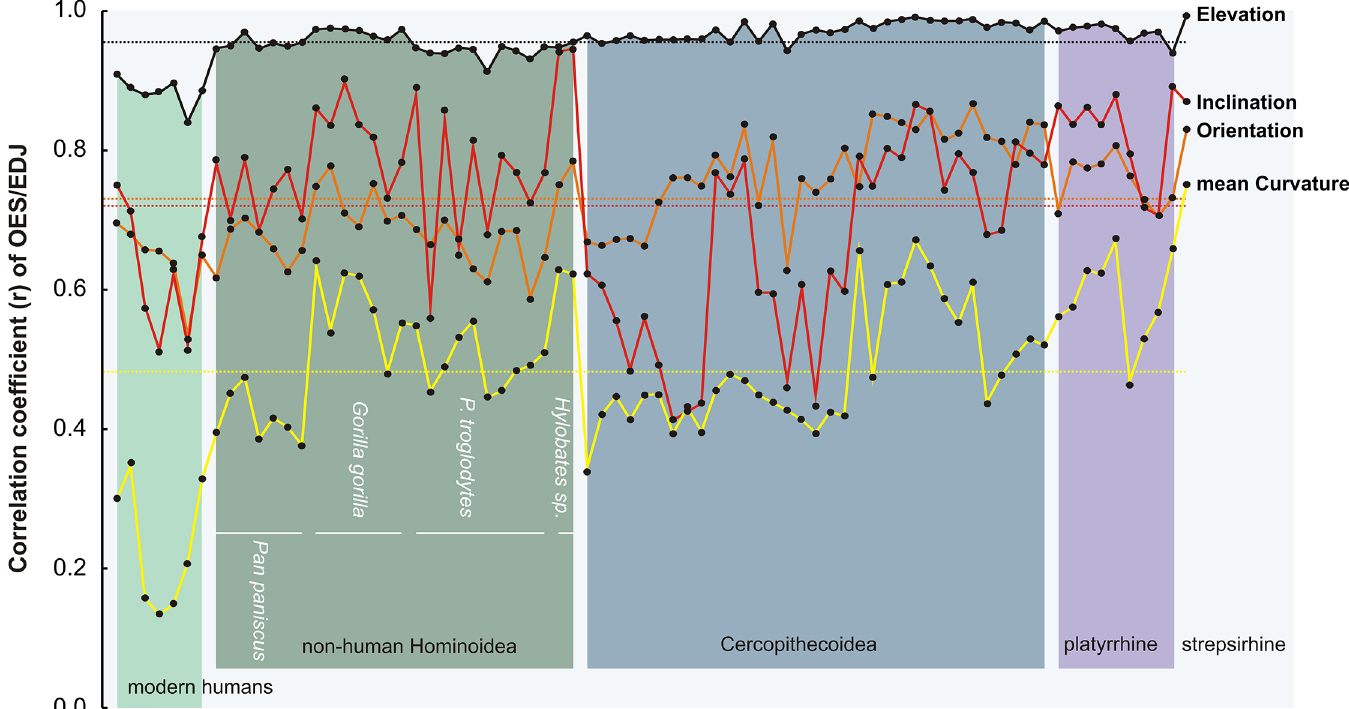
Fig 2. Level of correlation between EDJ and OES for topometrical signifiers within the primate sample The correlation coefficient (r) is displayed for elevation (black profile), inclination (red), orientation (orange) and mean curvature (yellow) for each specimen (black dot) Dotted lines correspond to the average correlation level for each topometrical